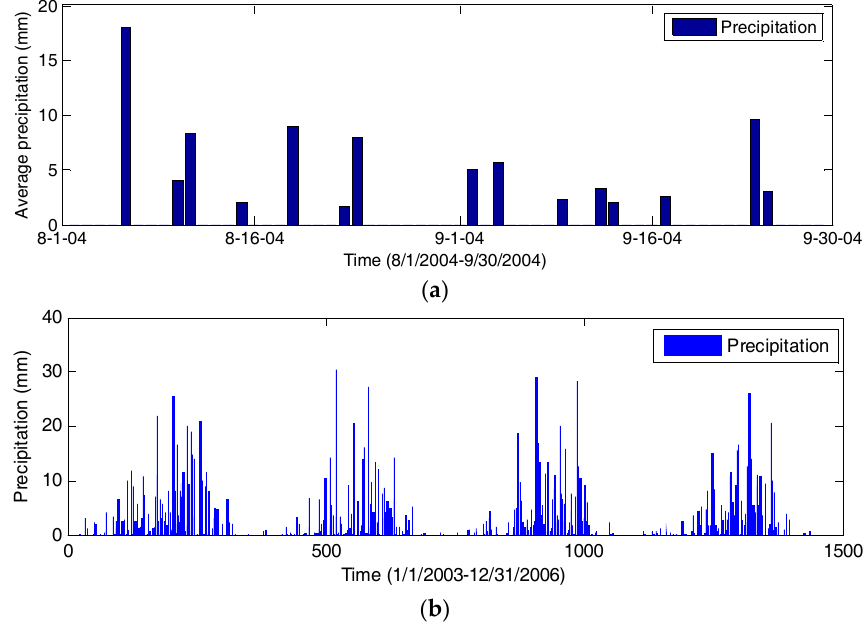
Figure 7. Averaged observed precipitation in the Zamask-Yingluoxia subbasin: ( a ) Precipitation from August to September 2004; ( b ) Precipitation from January 2004 to December 2006.